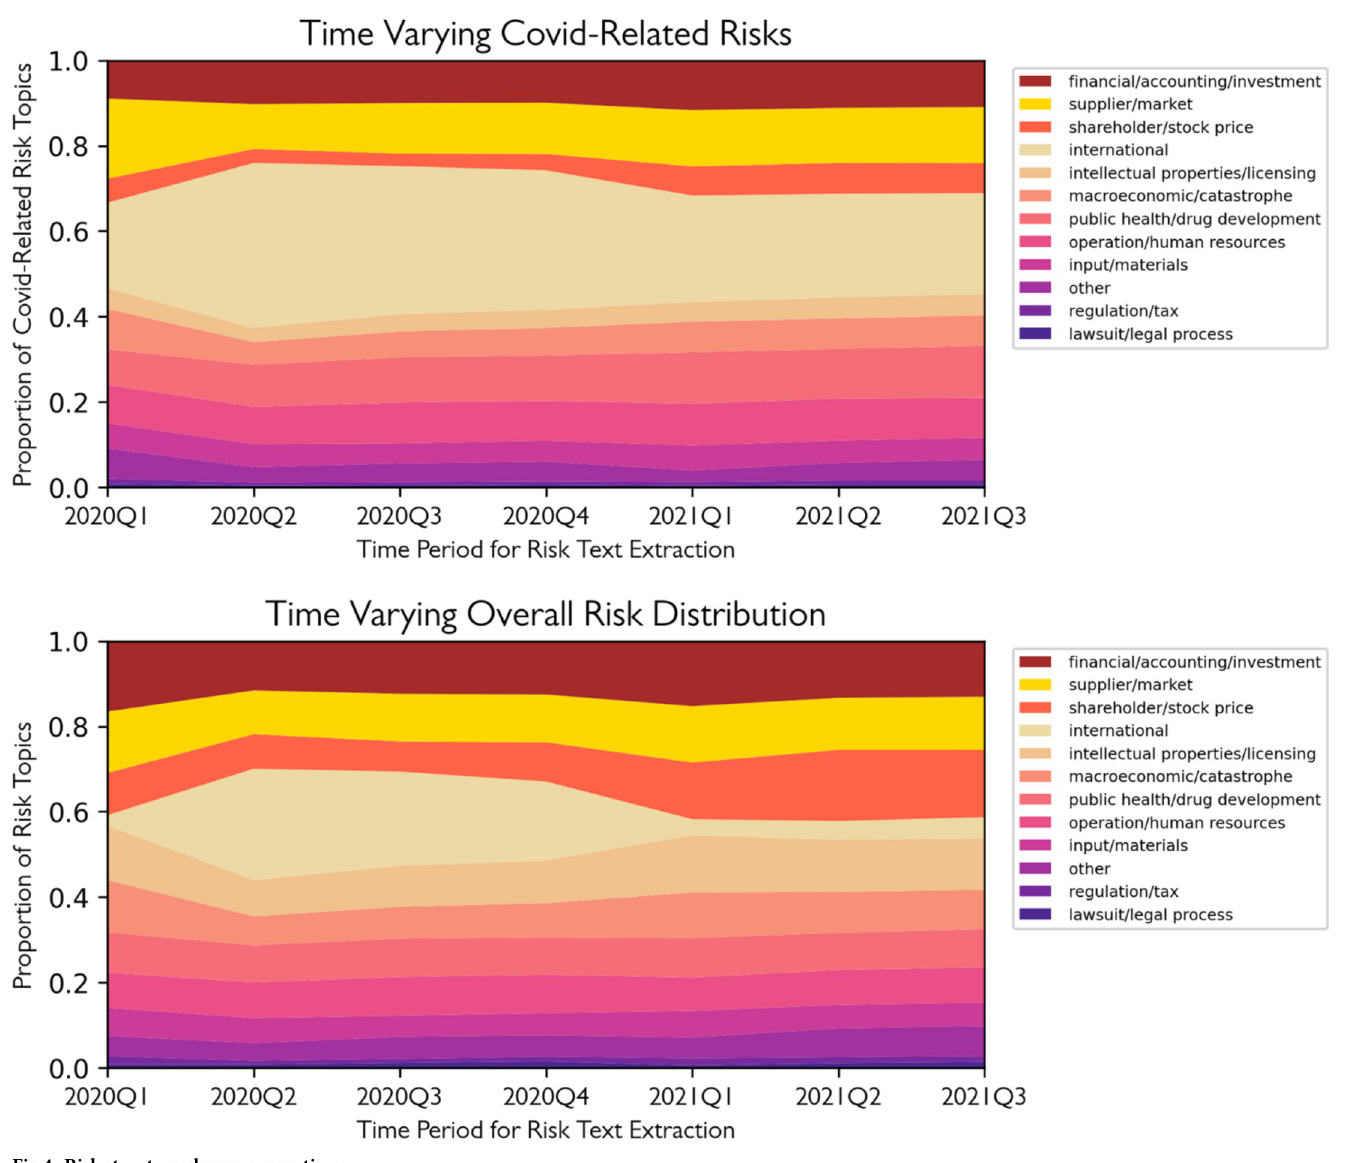
Fig 4. Risk structure change across